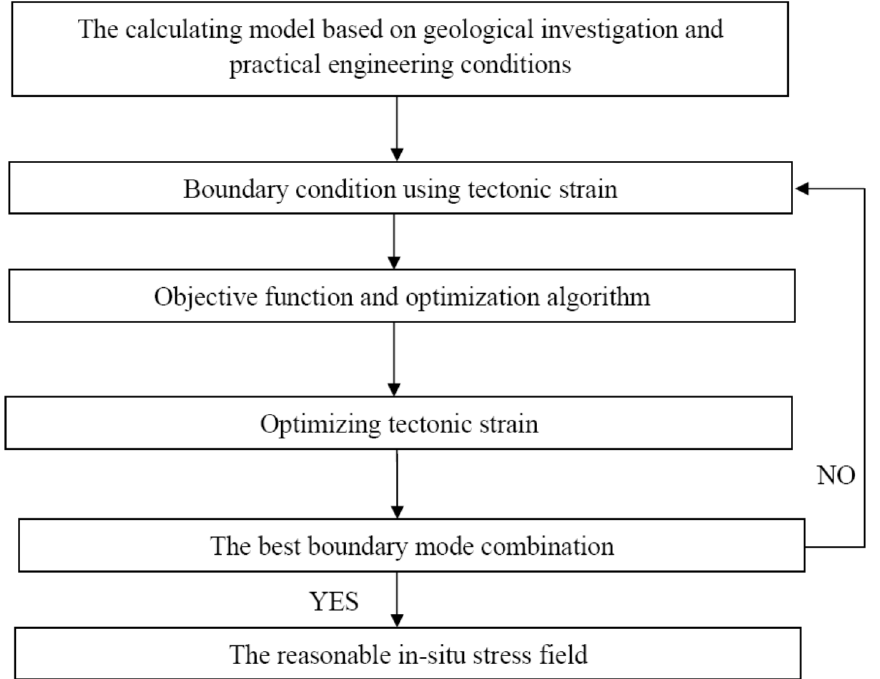
Figure 4. Calculating process of the proposed method. Based on aforementioned analysis, the tectonic strain tensor containing six unknown variables can be expressed as Equation (25). Therefore, for the proposed approach, the displacement boundary conditions can be applied on each lateral boundary as Equations (26)–(28), Equation (26) is for the displacement along the axis X, Equation (27) is along the axis Y, and the Equation (28) is along the axis Z on each lateral boundary ABEF, BCDE, CODG and AOGF in Figure 3. Therefore, in this approach the displacement boundary mode for the 3-D calculating model can be summarized as Equation (29):